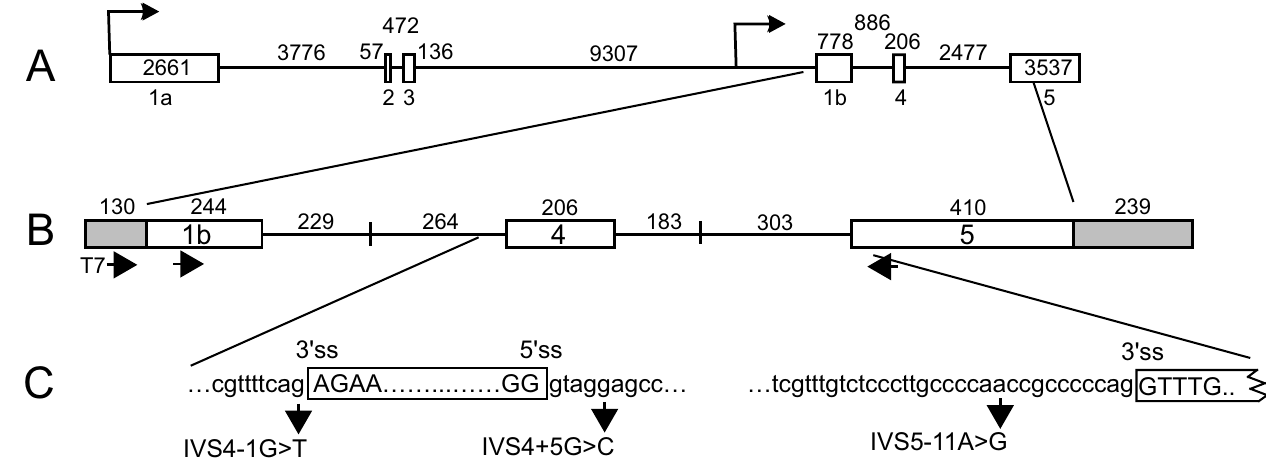
Figure 2 PITX2 gene and minigene structure . A. Schematic of PITX2 gene organization (drawn to scale). Open boxes represent exons, lines represent introns. The sizes of exons and introns are shown. The PITX2 gene has two major promoters (arrows) and six exons. Alternative splicing and transcription start sites give three major isoforms (not shown). PITX2c uses the down- stream promoter and produces an mRNA containing exon 1b, 4, and 5. B. Schematic of PITX2c minigene. The minigene con- tains a portion of exon 1b, exon 4, part of exon 5, and uses the CMV promoter and bGH polyadenylation site from the pcDNA3.1/ myc -His(-)A vector (transcribed vector sequences are represented by shaded boxes). The lengths of intron regions associated with each exon are shown with vertical lines indicating the fusion of two fragments. The positions of the T7 primer to vector sequences, and primers to PITX2 exons 1b and 5 that were used for RT-PCR are shown below the diagram. C. Expansion of (B) showing the names and locations of three different intronic point mutations identified in ARS patients. The sequence surrounding the 5' and 3' splice sites of exon 4, and the 3' ss of exon 5 is shown. Mutations in patients 0175